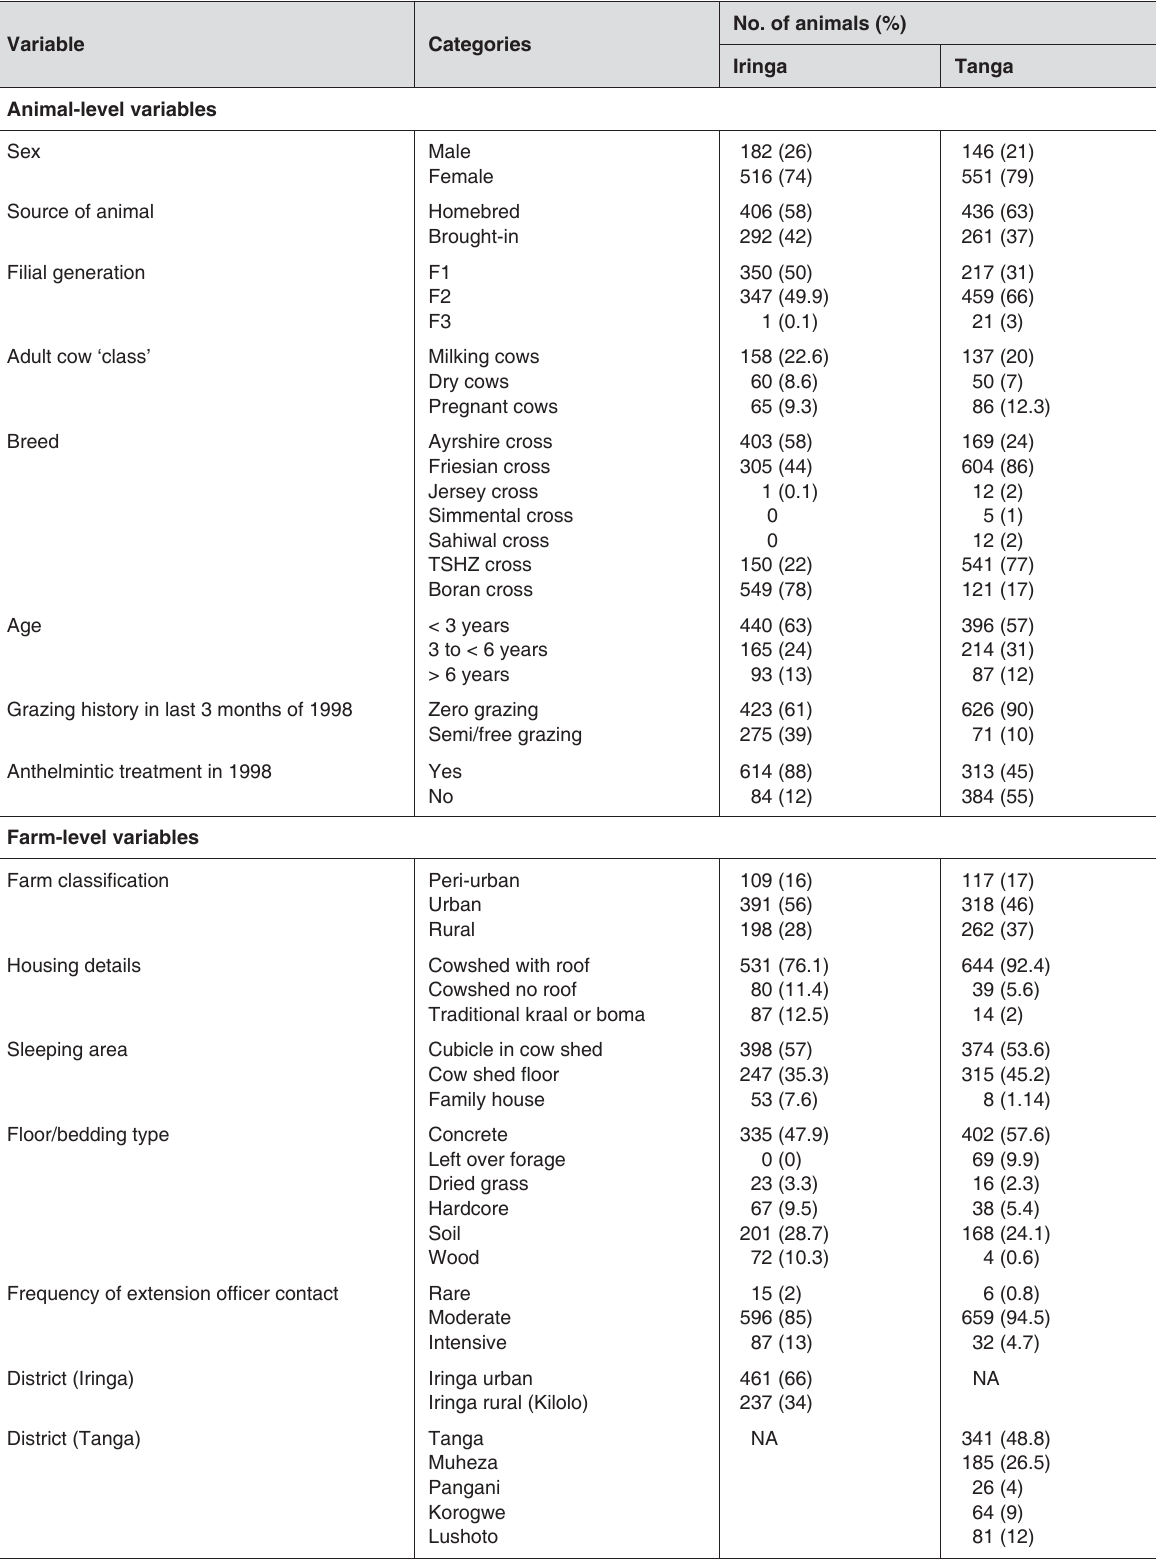
TABLE 1 The proportions of cattle in each category of each variable investigated during the study